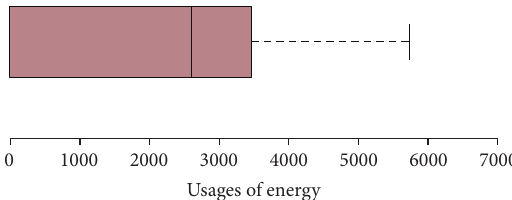
Figure 6: Distribution of appliance energy consumption. The black line in the figure shows where the median is placed.